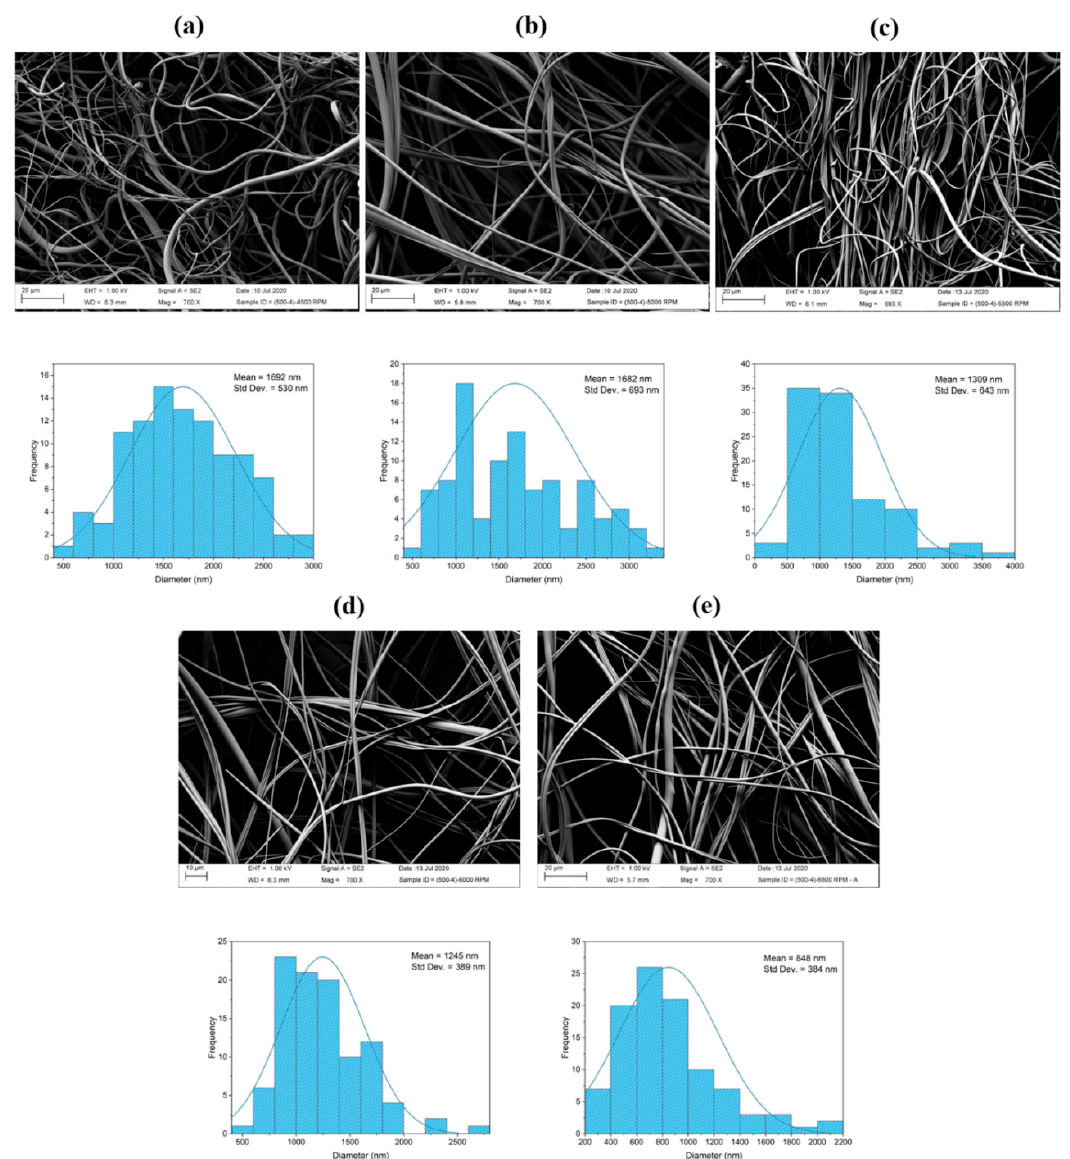
Figure 10. SEM micrographs and corresponding fiber diameter distribution profiles of PVA fibers forcespun with various rotational speeds: ( a ) 4500, ( b ) 5000, ( c ) 5500, ( d ) 6000, and ( e ) 6500 rpm.